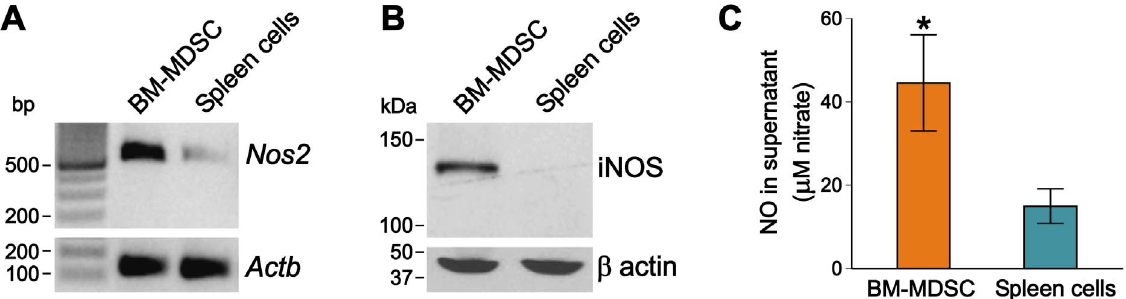
Figure 4. Expression and activity of iNOS in BM-MDSCs. ( A ) Comparison of murine iNOS ( Nos2 ) transcript levels in BM-MDSCs and spleen cells revealed that iNOS mRNA was upregulated in BM-MDSCs. The housekeeping gene ( Actb , encoding b -actin) was expressed at equal levels. Results of one of 2 replicate experiments (with similar results) are shown. ( B ) Western blot using an antibody against murine iNOS demonstrated the presence of iNOS protein in BM-MDSCs, but not in spleen cells. The b -actin control blot shows equal sample loading. One of 3 independent Western blots is shown. ( C ) iNOS activity was assayed on the basis of NO release into the supernatants of cultures containing BM-MDSCs (orange bar) or spleen cells (green bar), and expressed as total nitrate concentration ( m M). BM-MDSC-containing cultures produced significantly higher amounts of NO than spleen cells did (*p , 0.05, n=5 cultures/cell type; Mann-Whitney U test). Molecular markers: bp, base pairs; kDa, kilodalton.